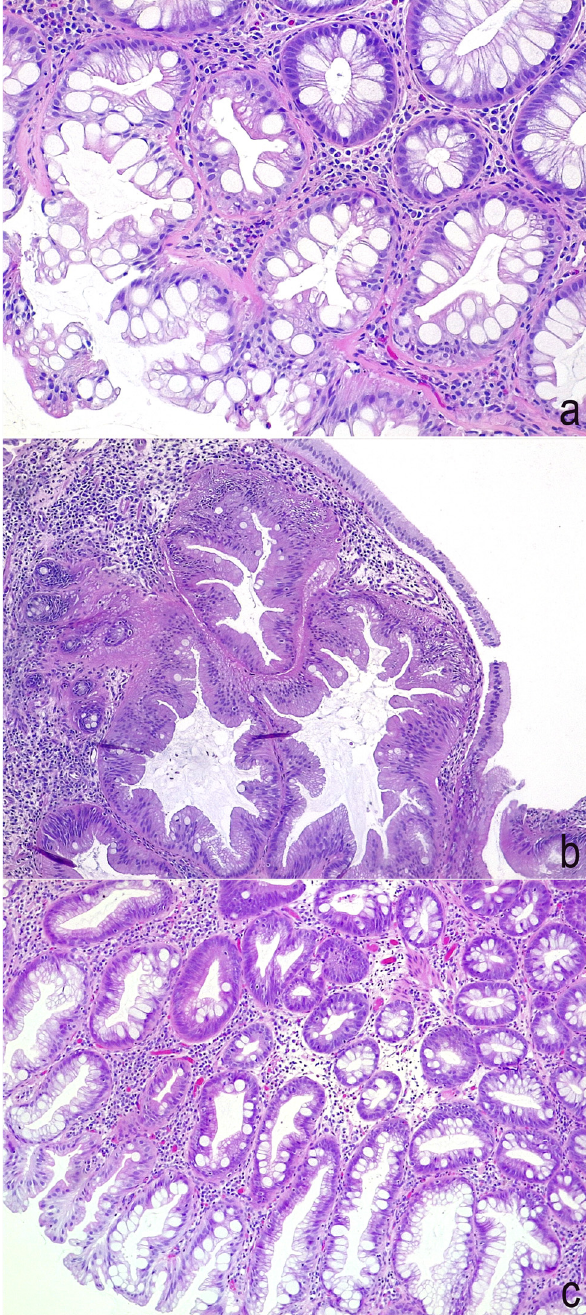
Figure 1: Histopathologic features of serrated lesions. ( a ) Goblet cell - rich hyperplastic polyp. The crypts show the typical sawtooth architecture, which is more evident super fi cially and contain a large number of goblet cells. ( Hematoxylin and eosin stain, 200 × mag - ni fi cation. ) ( b ) Sessile serrated lesion. Deep serration and basal crypt dilation can be observed in the present fi eld. ( Hematoxylin and eosin stain, 100 × magni fi cation. ) ( c ) Sessile serrated lesion with dysplasia. Besides crypt serration and dilation, low - grade dys - plastic foci can be observed in the present case. ( Hematoxylin and eosin stain, 100 × magni fi cation.